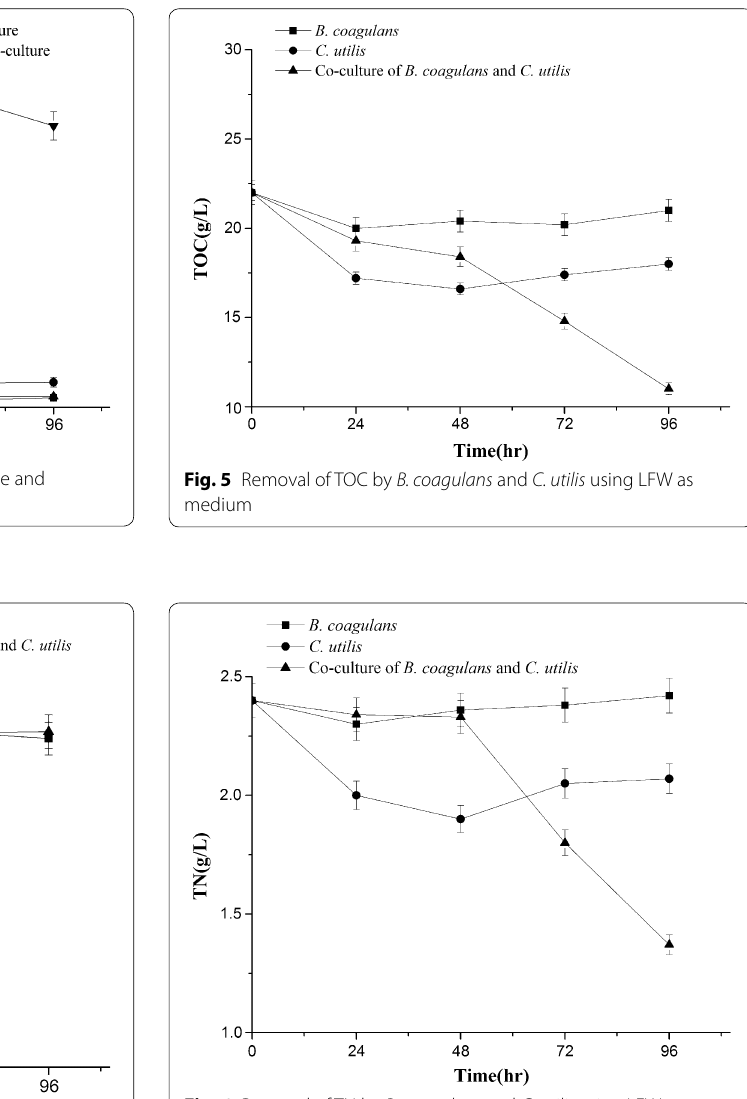
Fig. 6 Removal of TN by B. coagulans and C. utilis using LFW as